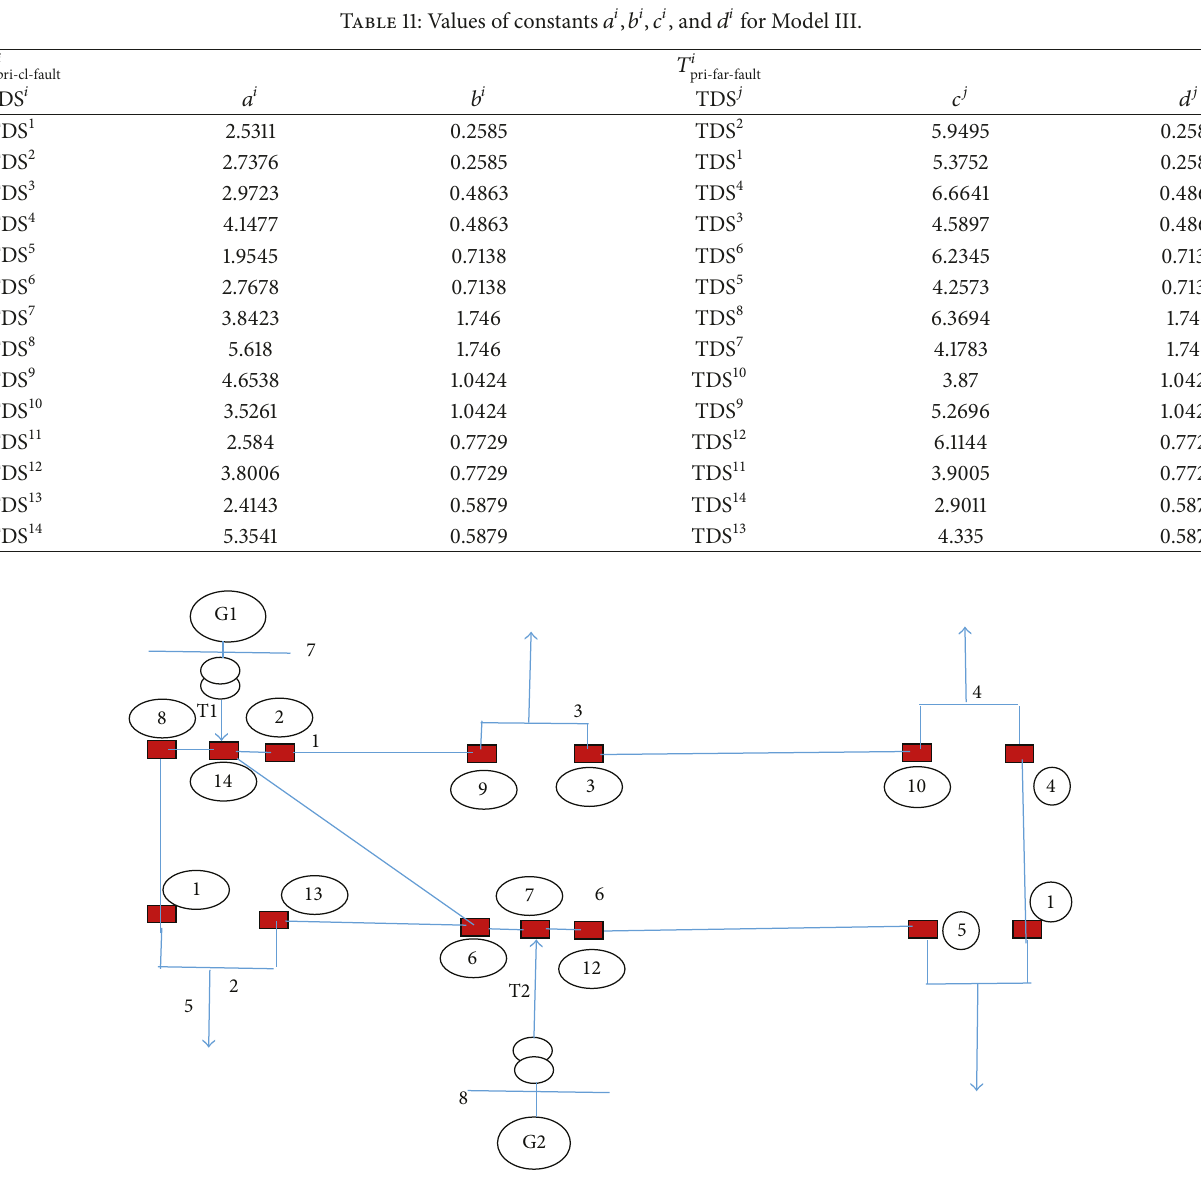
Figure 11: Model for the IEEE 8-bus system